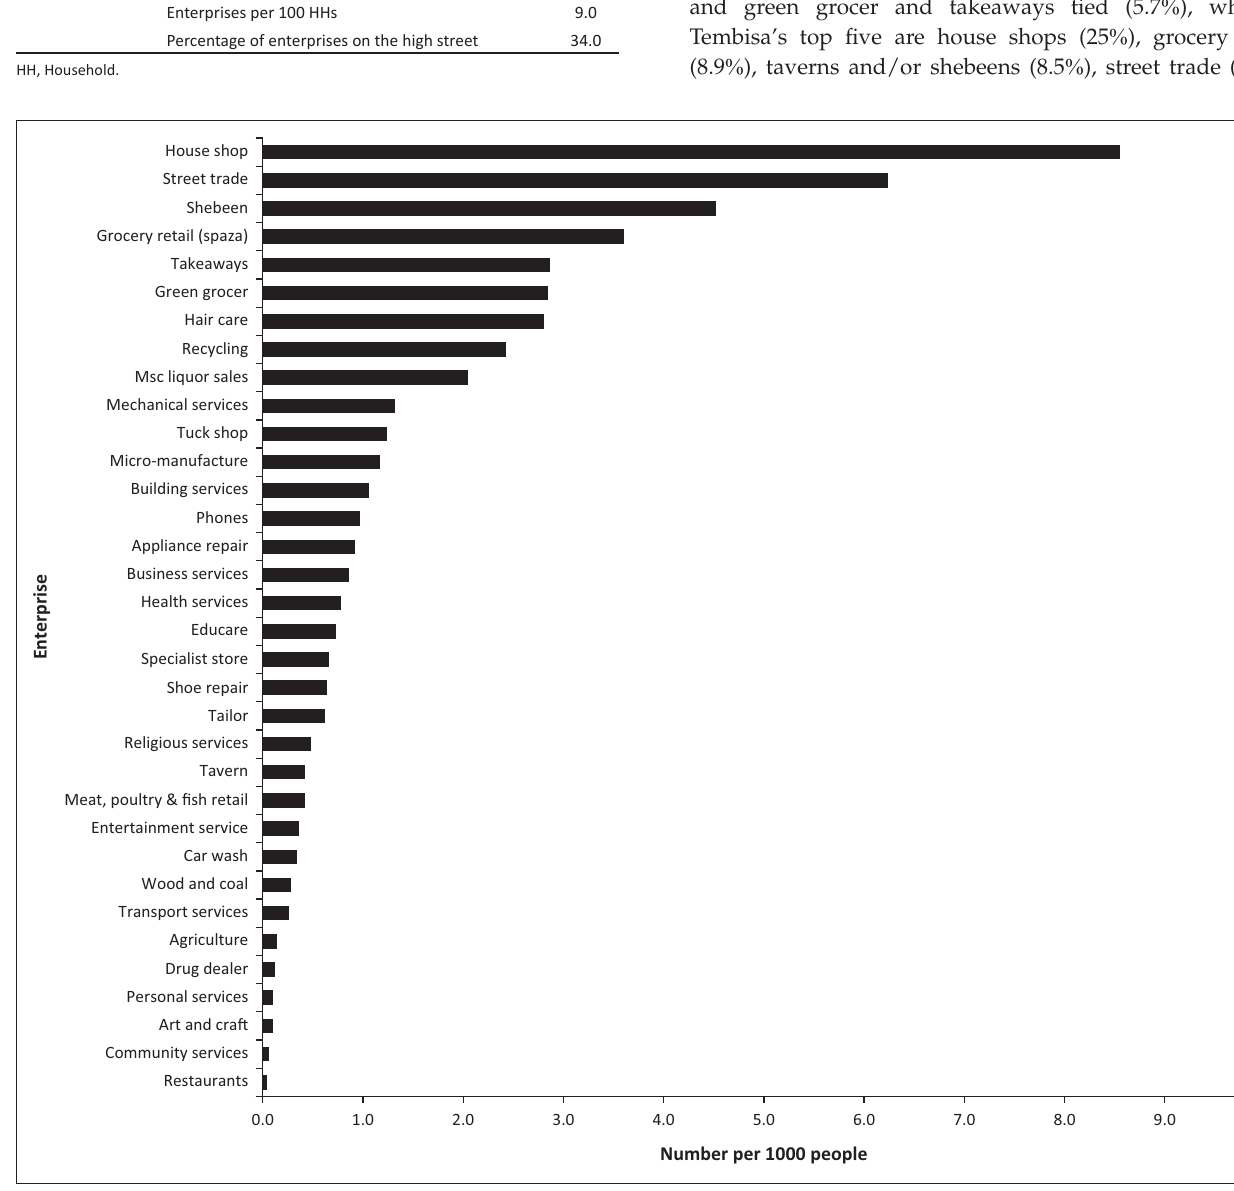
FIGURE 1: Ivory Park, enterprise activities per 1000